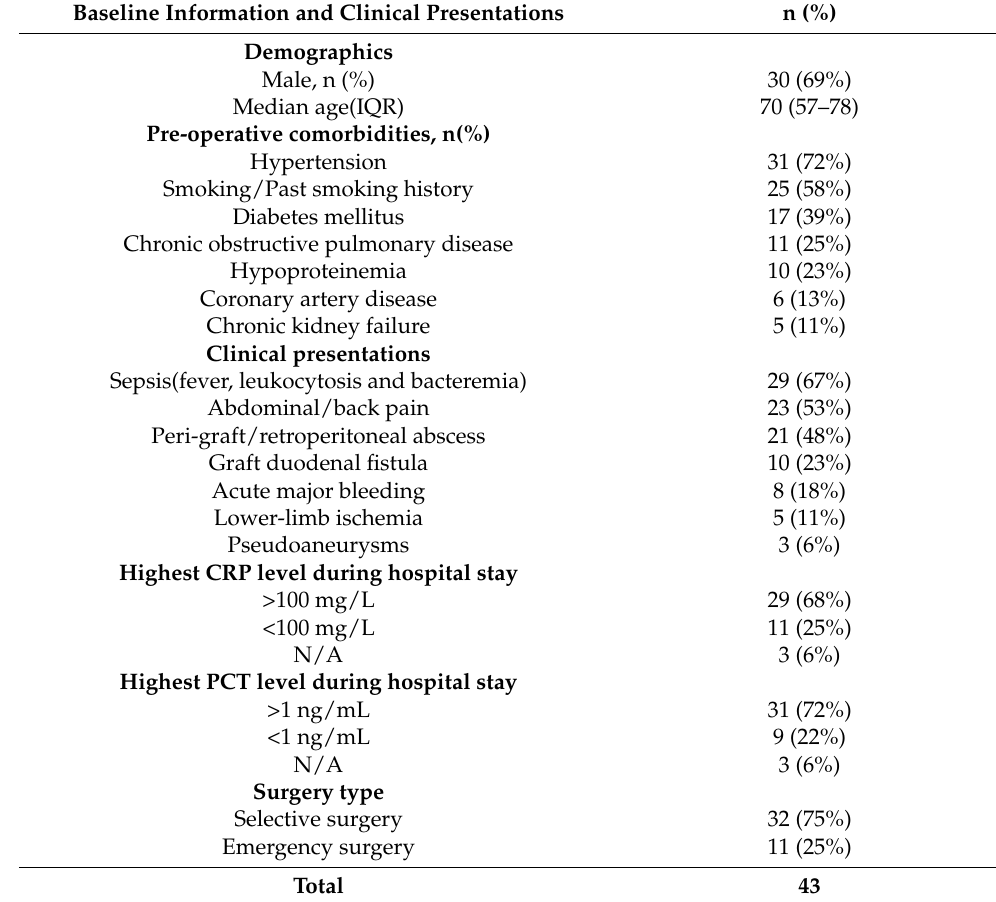
Table 1. Baseline information and clinical presentation of patients with